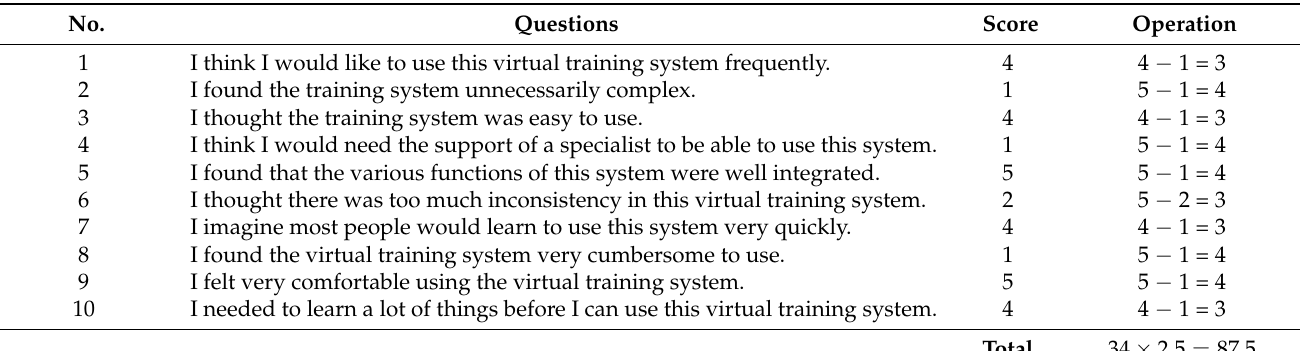
Table 3. Usability Testing